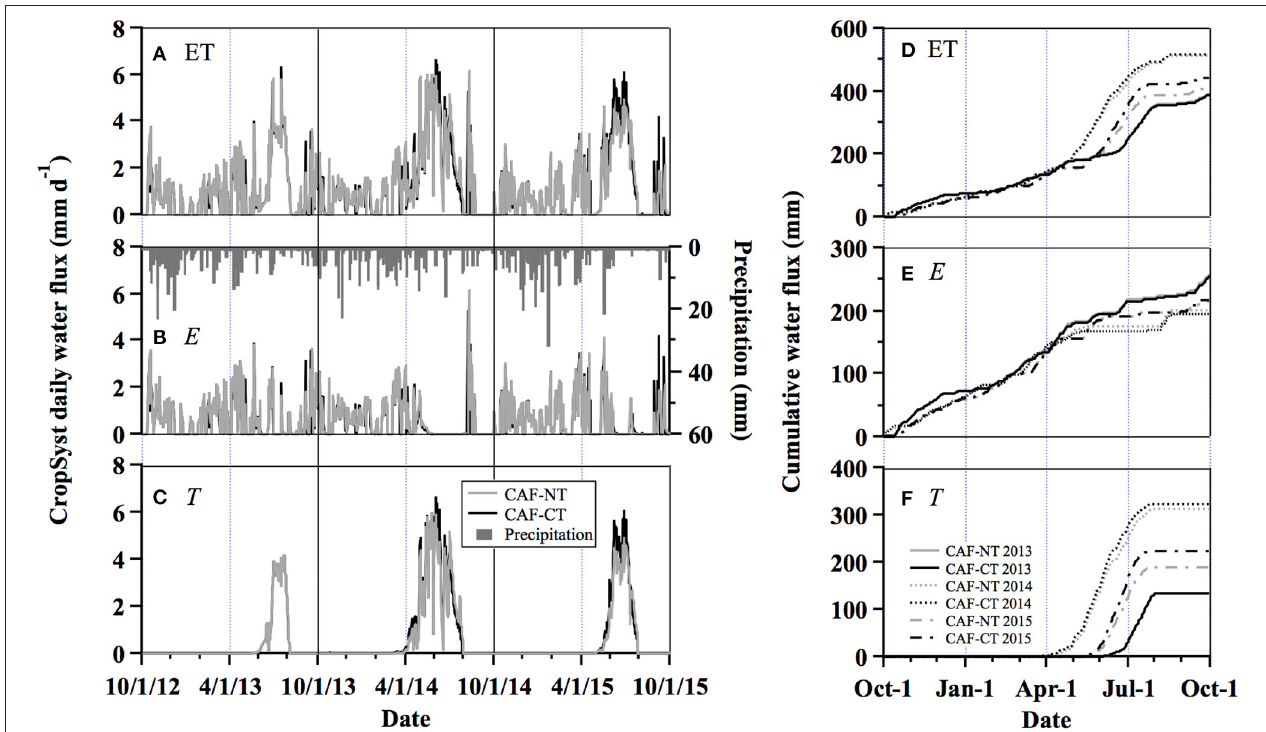
FIGURE 6 | CropSyst daily (A–C) and cumulative (D–F) evapotranspiration (ET), soil water evaporation ( E ), and crop transpiration ( T ) at the no-till (CAF-NT) and the conventional tillage (CAF-CT) sites from October 1, 2012 to September 30, 2015. Daily precipitation measurements were only plotted for CAF-NT to represent the general precipitation conditions at